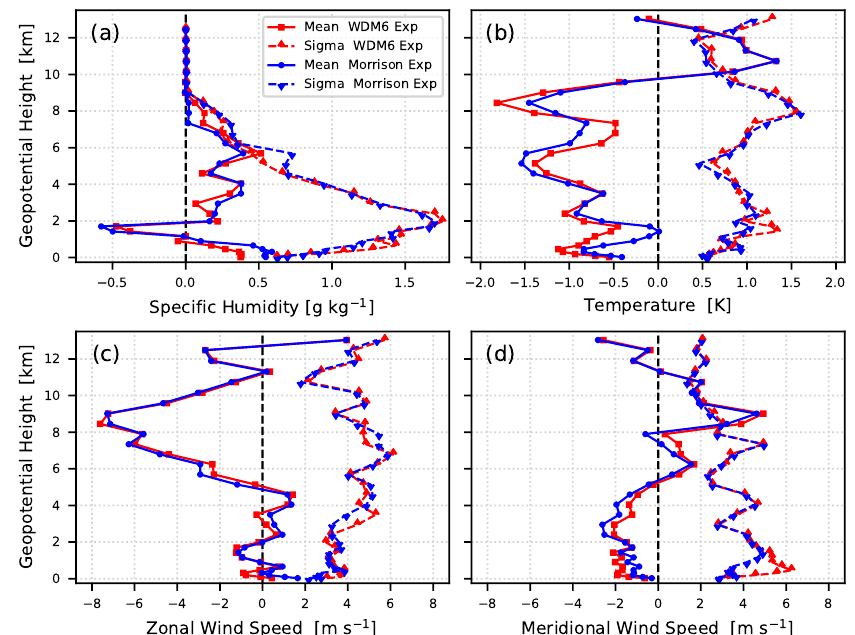
Figure 6. Difference between the numerical experiments and the measurements from all dropsondes released during the research flight for ( a ) specific humidity (g kg − 1 ), ( b ) temperature (K), ( c ) zonal component of wind speed (m s − 1 ), and ( d ) meridional component of wind speed (m s − 1 ). The solid curves are the mean difference between model and dropsondes (i.e., model minus observation), and the dashed curves are the standard deviation of this difference, with red and blue curves indicating the WDM6 and Morrison experiments,